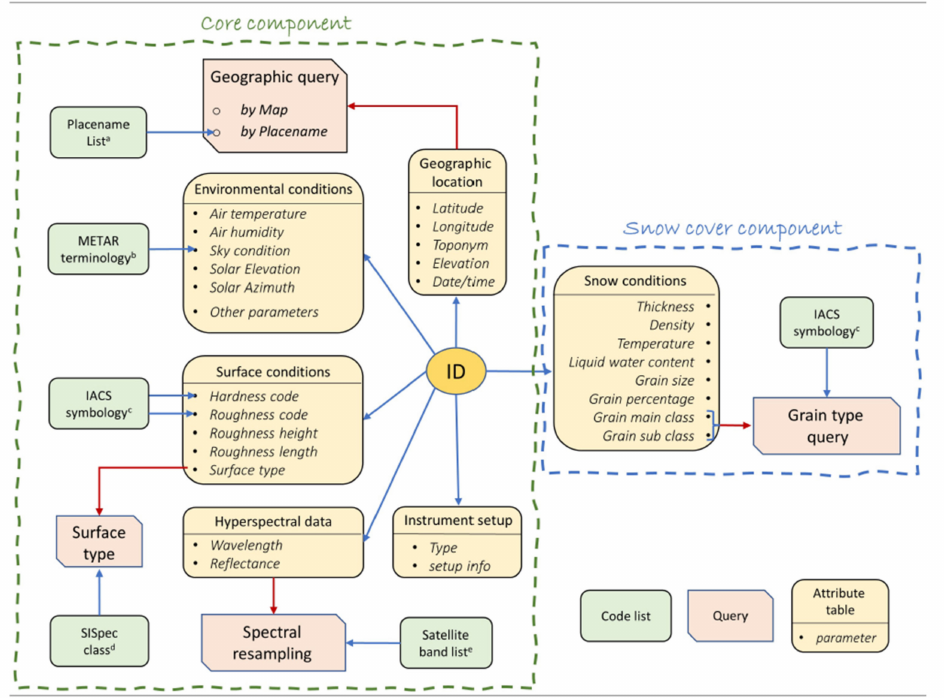
Figure 3. Database structure and relational tables breakdown: the core and nivological components are characterized by attribute tables, functionalities, and code lists. a is the placename list defined in [32], b refers to the METAR terminology reported in [20], c refers to the IACS classification [20], d are the classes defined in this paper combining [20,31], e are the bands declared by each satellite platform